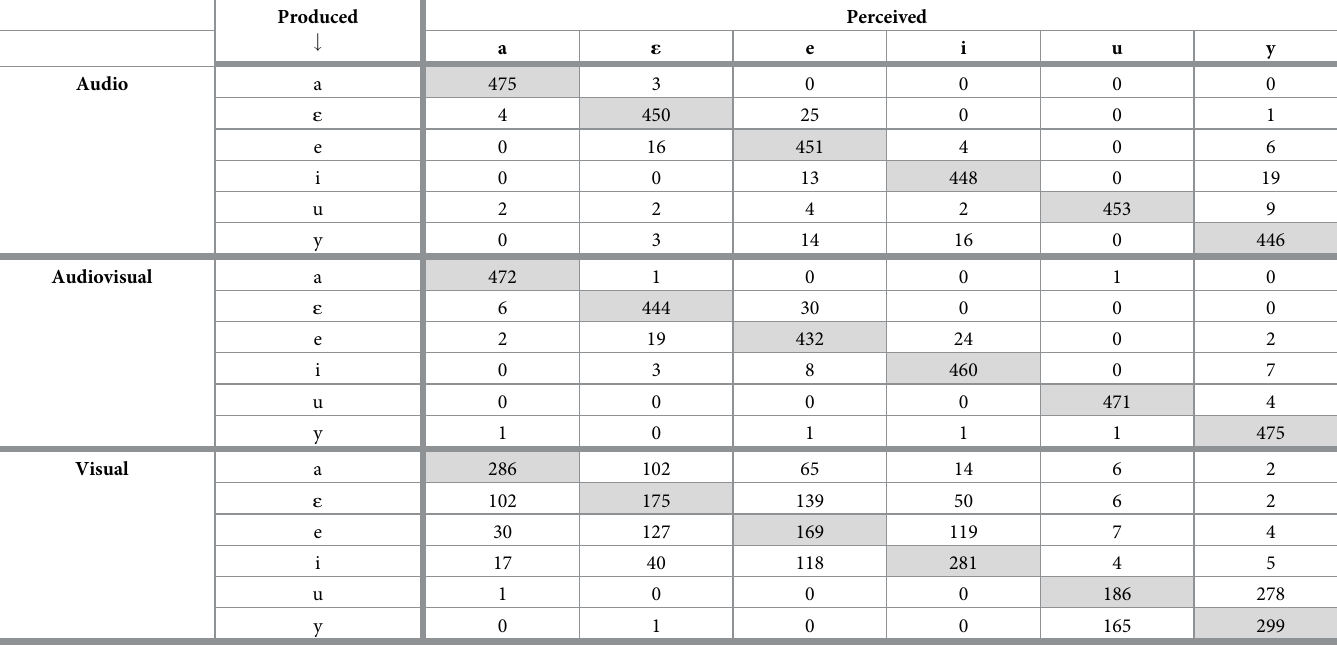
Table 3. Confusion matrices for vowels produced by the blind speakers in experiment 1.